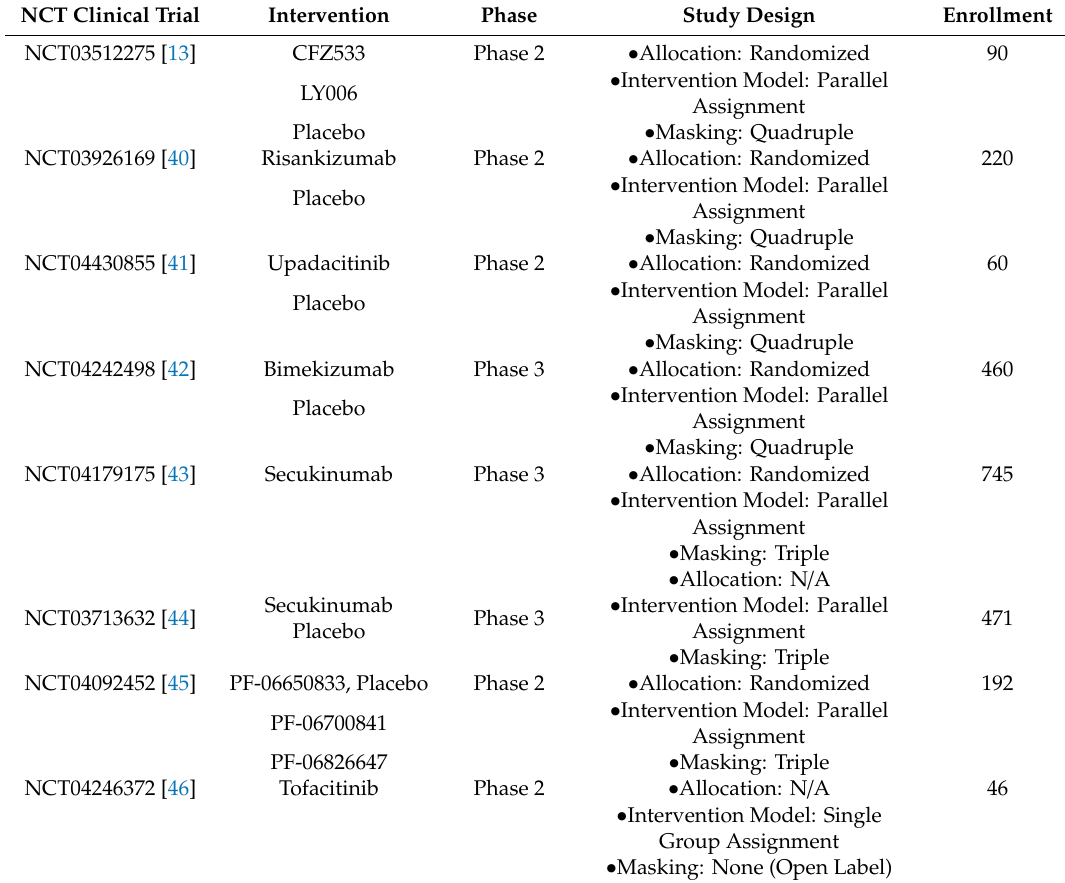
Table 2. Recruiting interventional studies on target